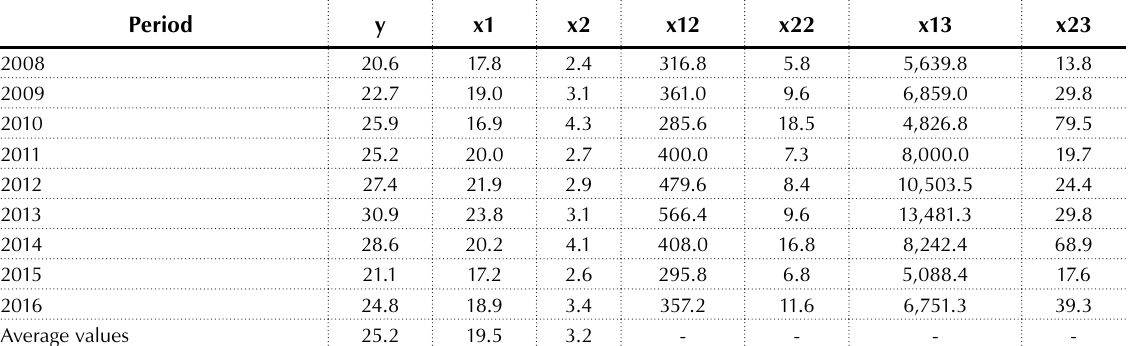
Table 2. Statistical basis of